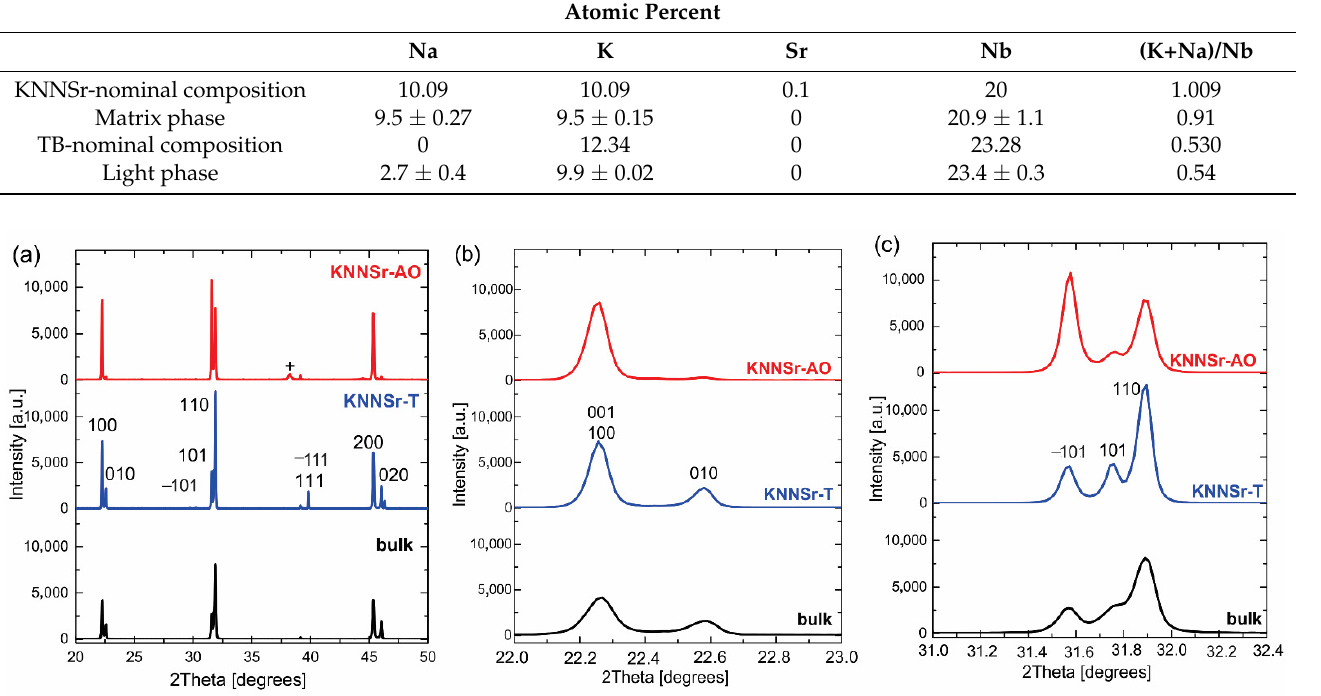
Figure 6. ( a ) X-ray powder diffraction (XRD) patterns of KNNSr-T, KNNSr-AO in KNNSr bulk; ( b ) enlarged view in 2 Theta range 22–23 degrees; ( c ) enlarged view in 2 Theta range 31–32.5 degrees.